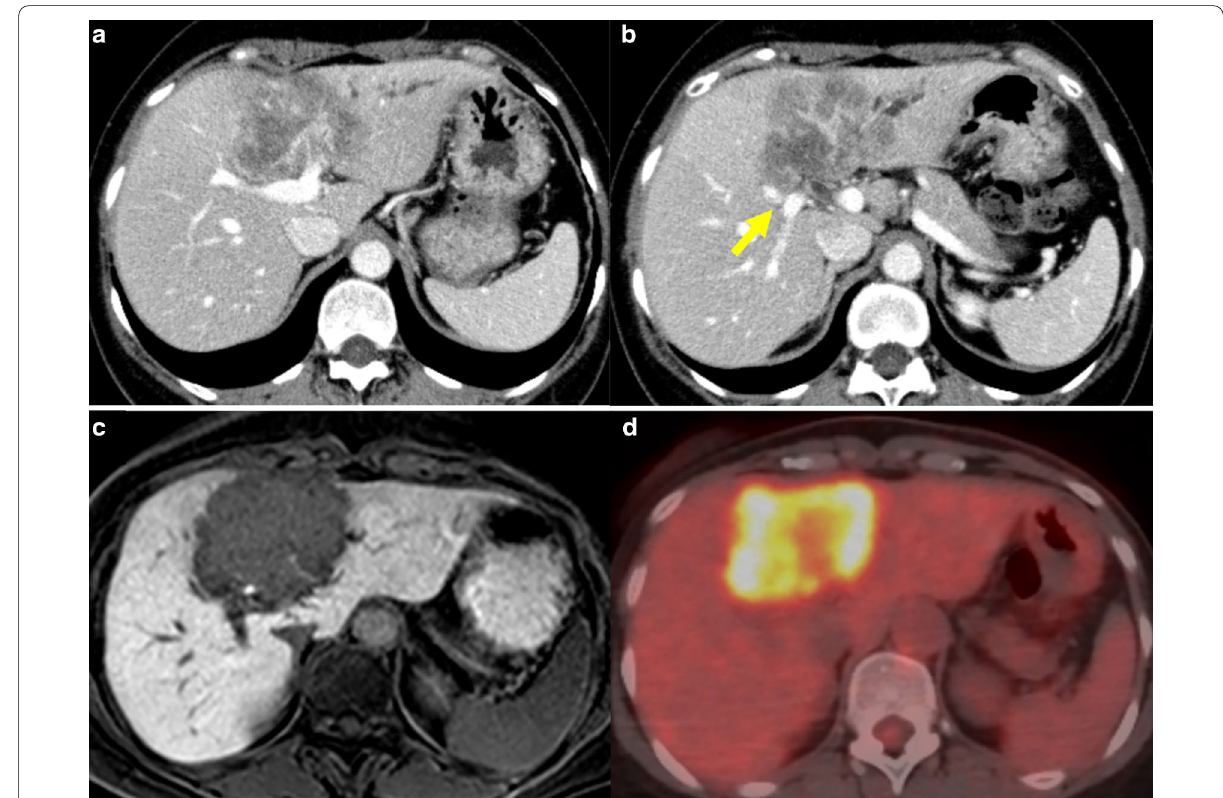
Fig. 1 Images at admission of local hospital. a Contrast-enhanced abdominal computed tomography (CT) showed the tumor was mosaic enhancement, measured 65 61 mm in the hepatic segments 4 and 5 and 8. b Contrast-enhanced abdominal CT showed the tumor was attached × to the biliary confluence, bifurcation of anterior–posterior Glissonian (yellow arrow) and right portal vein trunk. It was suspected to invasion to the left portal vein trunk, left intrahepatic bile duct and middle hepatic vein. c Magnetic resonance imaging (MRI) showed the tumor was hypointense on T1-weighted images. The margin of the tumor was unclear. d 18 F-fluorodeoxyglucose (FDG)-positron emission tomography/computed tomography showed high FDG uptake of tumor with standardized uptake value-max of